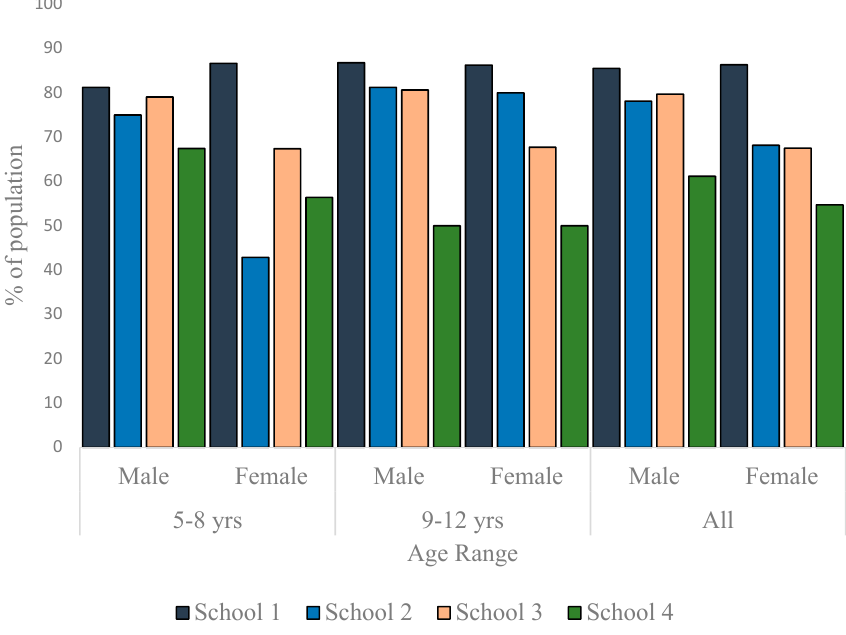
Figure 4. Distribution of normal weight children in the studied schools.